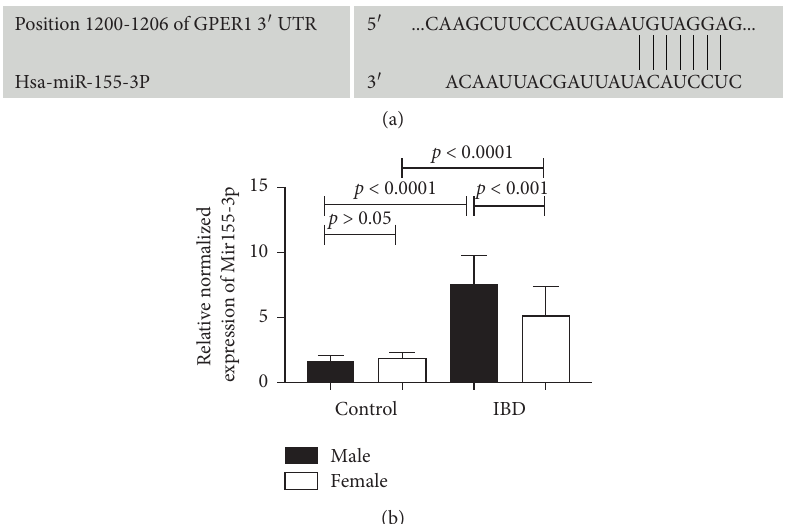
Figure 3: MiR-155 is involved in the regulation of GPER1. (a) GPER1 is a target of miR-155. (b) The expression of miR-155 in the colon tissues of IBD patients and the control group. The values are presented as the mean ±